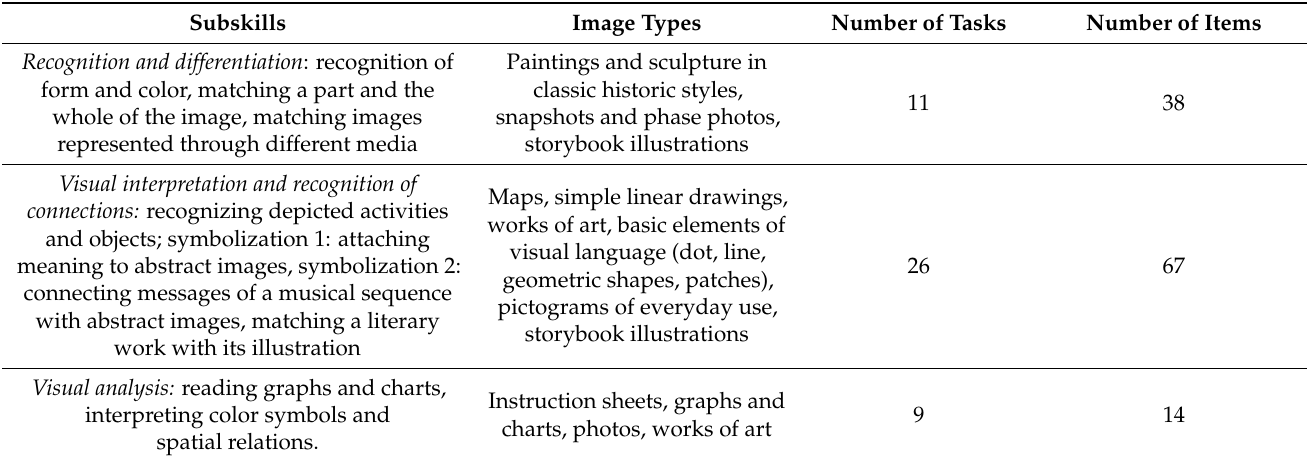
Table 3. The system of tasks and visual patterns in the test according to the primary skill elements.